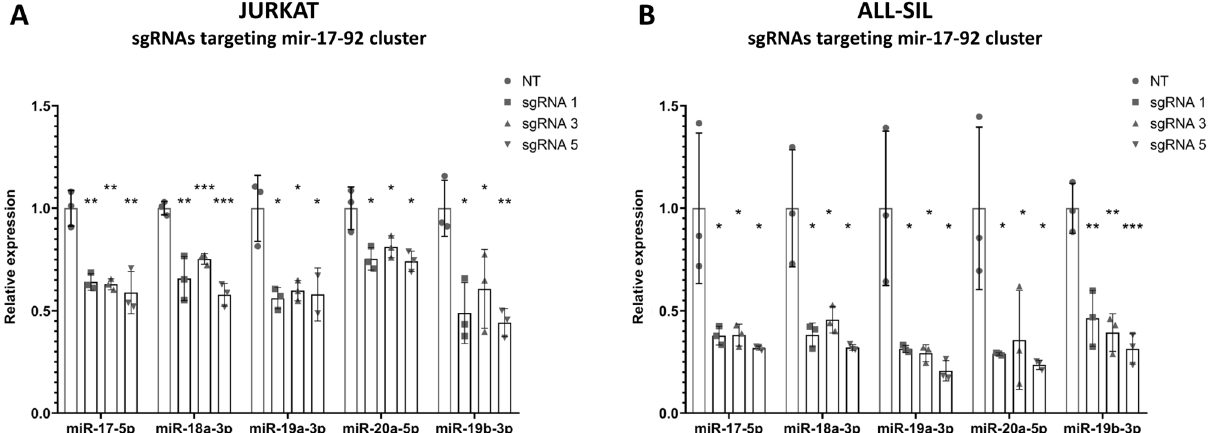
Figure 3. Expression of miRNAs encoded within mir-17–92 cluster upon dCas9-KRAB-mediated inhibition of this locus. ( A ) Normalized expression of miR-17-5p, miR-18a-3p, miR-19a-3p, miR-20a-5p and miR-19b-3p upon the use of three most effective sgRNAs targeting putative TSS of mir-17–92 cluster in JURKAT cell line. ( B ) Normalized expression of miR-17-5p, miR-18a-3p, miR-19a-3p, miR-20a-5p and miR-19b-3p upon the use of three most effective sgRNAs targeting putative TSS of mir-17–92 cluster in ALL-SIL cell line. Scr—scrambled control. * p < 0.05; ** p < 0.01; *** p < 0.001.